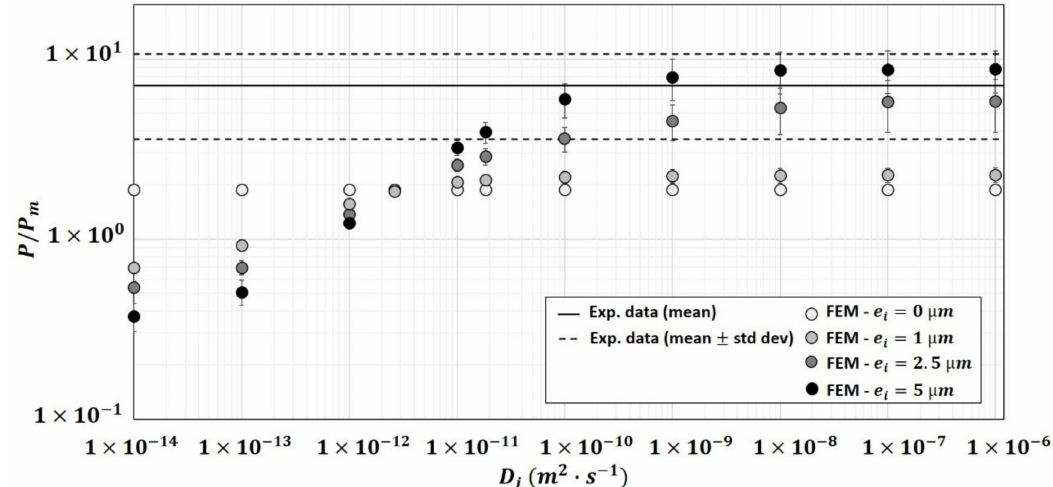
Figure 11. Evolution of the numerical relative permeability of the composite ( ϕ p = 19.52 % v / v ) as a function of the diffusivity of interphase and for different thicknesses of the interphase The numerical results (symbols) correspond to the average of the relative permeability of 14 structures ( e i = 1 µ m ) , 19 structures ( e i = 2.5 µ m ) and 6 structures ( e i = 5 µ m ) . Lines represent the experimental relative permeability for ϕ p = 19.52 % v / v : solid line for mean value, dashed lines for mean ± standard